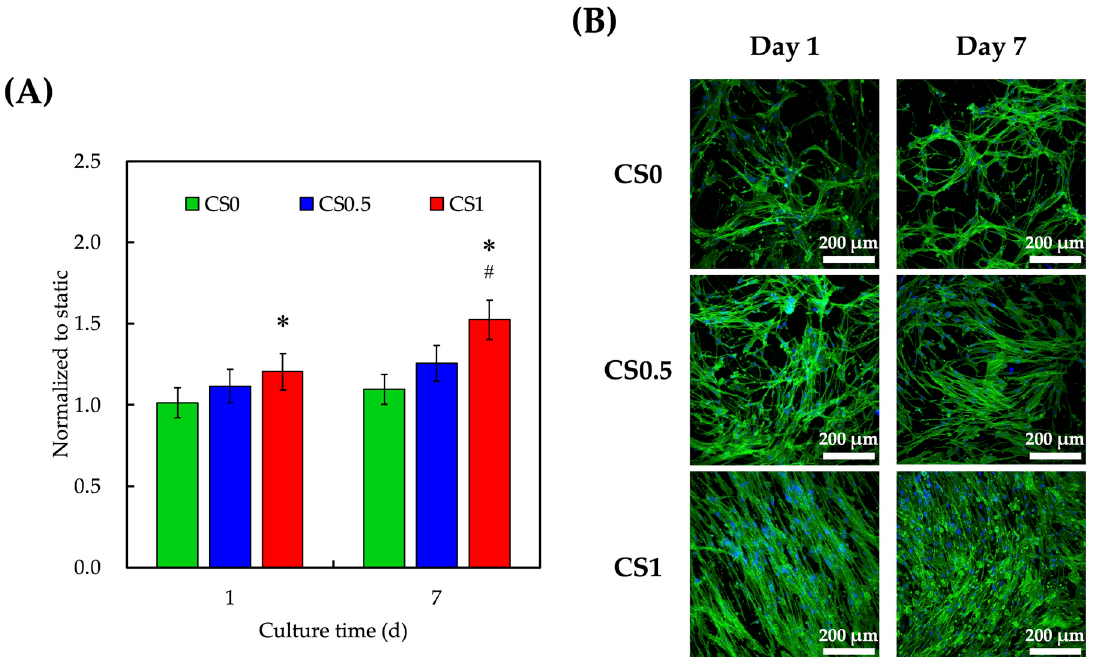
Figure 7. ( A ) Proliferation and ( B ) cell morphology of hPDLs-laden CS0, CS0.5, and CS1 after exposure to cyclic tensile stimulation. hPDLs growing on traditional culture dishes were used as Ctl. Data presented as mean ± SEM, n = 6 for each group. A p -value of < 0.05 was considered as a significant difference according to the calculation of Scheffe’s multiple comparison test. * represents significant differences when compared to CS0 and # represents significant differences when compared to CS0.5. Immunofluorescence images showed localization of F-actin and nucleus on day 1 and day 7 (green: F-actin; blue: nucleus; scale bar is 200 μ m).